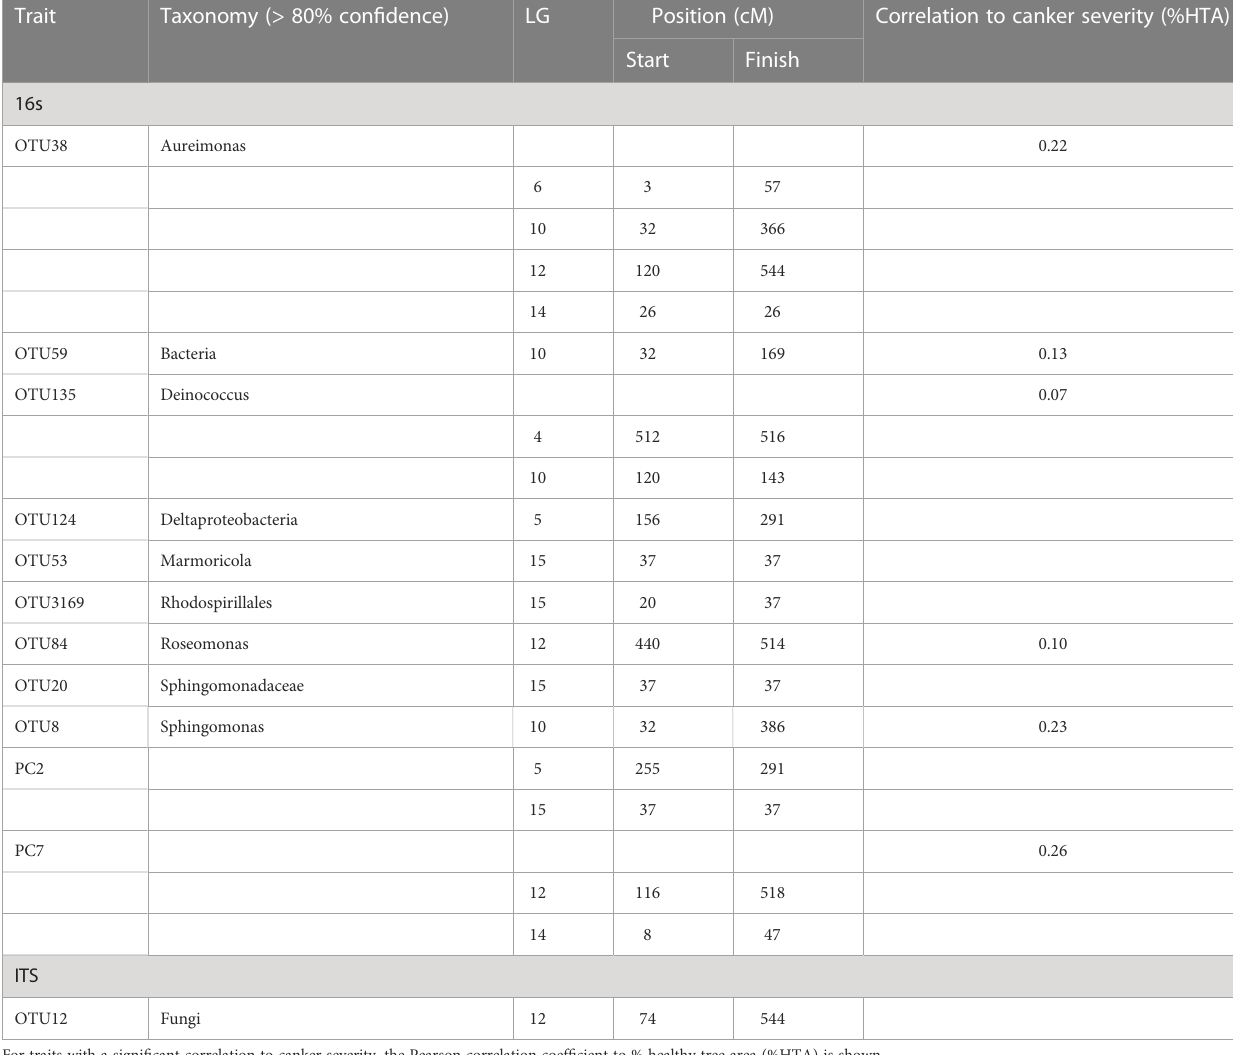
TABLE 2 Quantitative trait loci (QTL) identi fi ed from Kruskal-Wallist test for abundance data of bacterial (16s) and fungal (ITS) endophytes in apple leaf scar tissues of a full-sibling mapping population of ‘ Aroma ’ x ‘ Golden Delicious ’